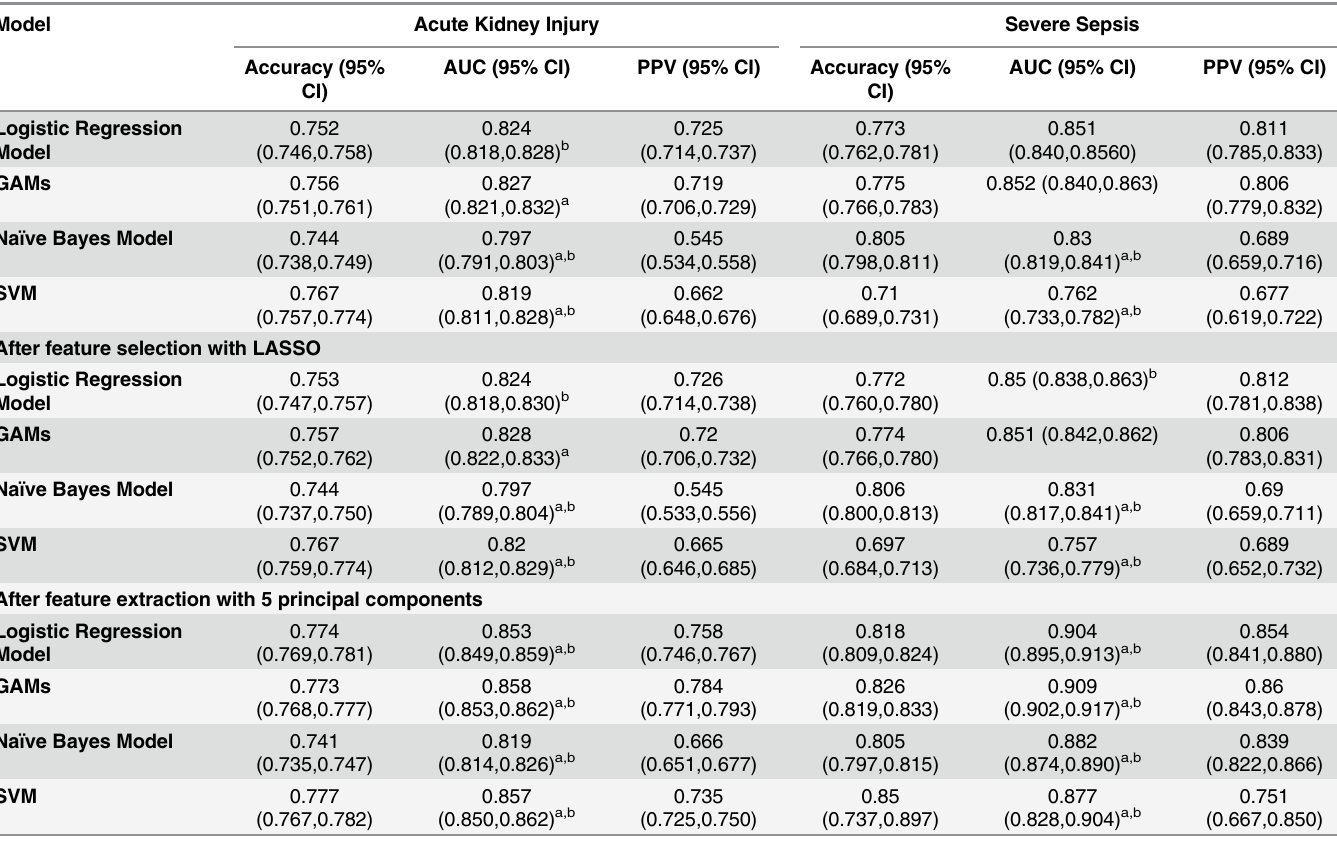
Table 4. Comparison of model performances. Abbreviations. AUC, area under the receiver operating characteristics curve; CI, confidence interval; GAM, generalized additive model; SVM, support vector machine; LASSO; least absolute shrinkage and selection operator; PPV, positive predicted value. Bootstrap sampling was used to obtain 95% confidence intervals and comparisons were made using nonparametric